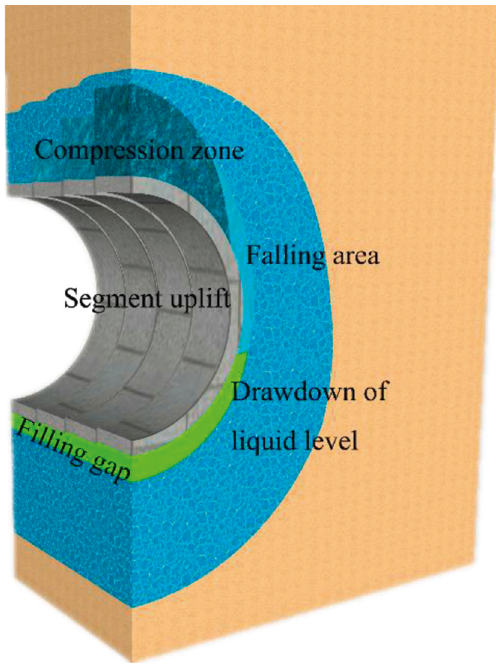
Figure 3: Segment floating